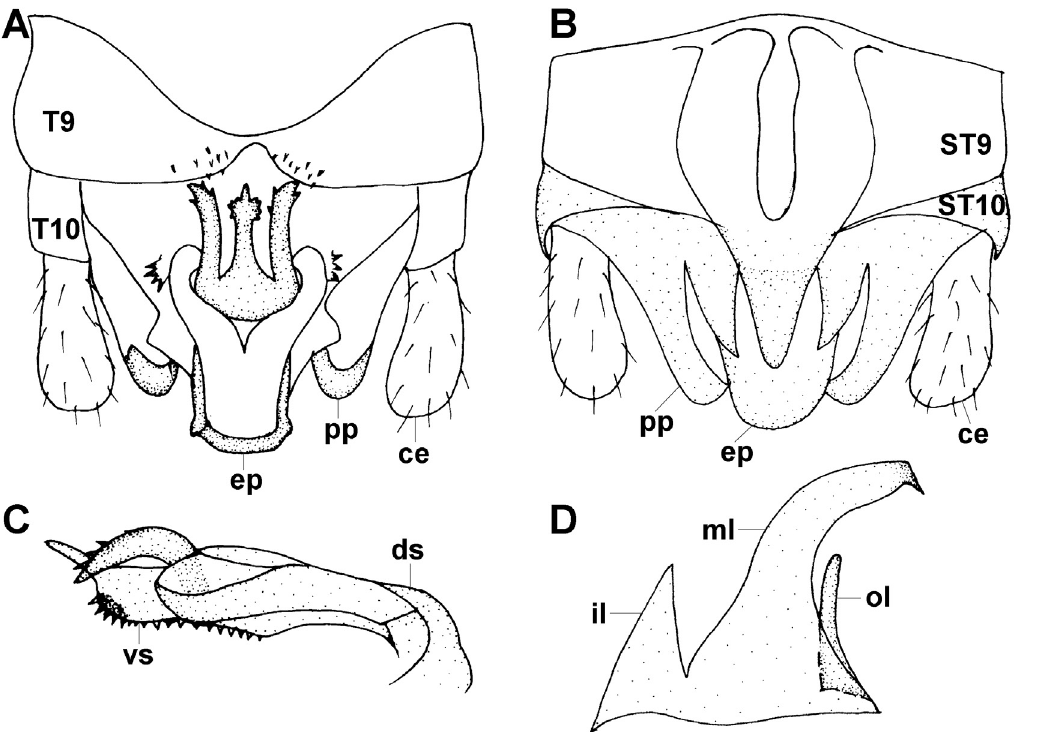
Fig. 12. Drawings of Amphinemura leigong Wang & Du, 2006. A . Male terminalia, dorsal view. B . Male terminalia, ventral view. C . Male epiproct, lateral view. D . Male paraproct, ventral view. Drawings modified from Yang et al . (2015). Scale bars unavailable from original source.